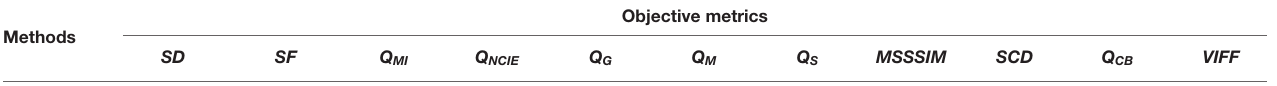
Objective metrics